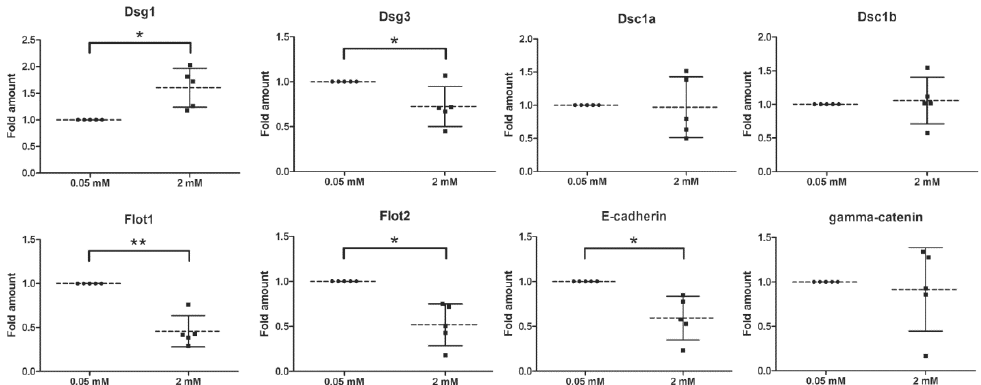
Figure 5. Effect of calcium concentration on the mRNA levels of adhesion proteins in hTert cells. The cells were grown in KGM with 0.05 mM calcium, then treated or not with 2 mM calcium for 24 h. RNA was isolated from the cells and quantitative real-time PCR was performed using the primers shown in Table 1. The ∆ Ct-method was used to quantify the PCR products. The mean of the reference genes RPL13a , GAPDH , Ywhaz and B2M was used for normalization. The signal in the 0.05 mM calcium sample was set to one, and the relative fold amount in the 2 mM sample was calculated. For statistical analysis, the unpaired Student’s t-test was used. Statistically significant differences are indicated by * p < 0.05, and ** p < 0.01. n = 5 independent experiments. Dotted line: Mean of samples, solid lines: SD.